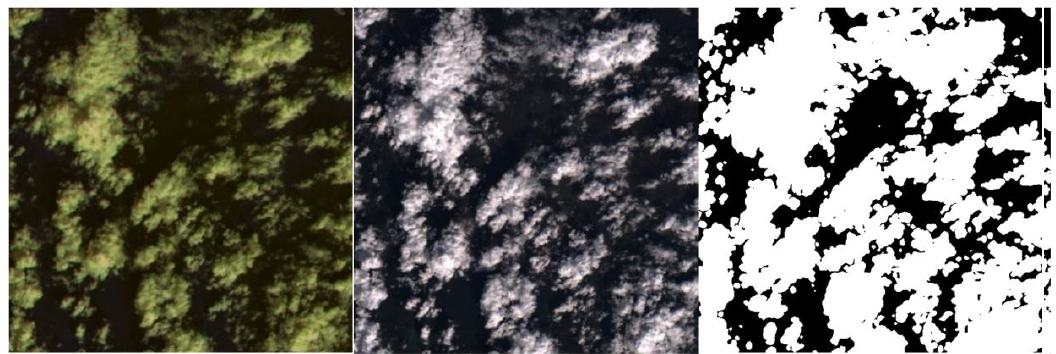
Figure 12. Pontchartrain clouds over water; radiance image, RGB image, cloud mask.